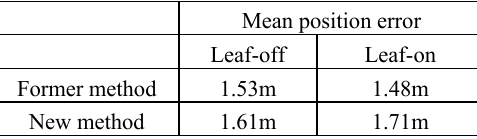
Table 7. Accuracy of the tree position